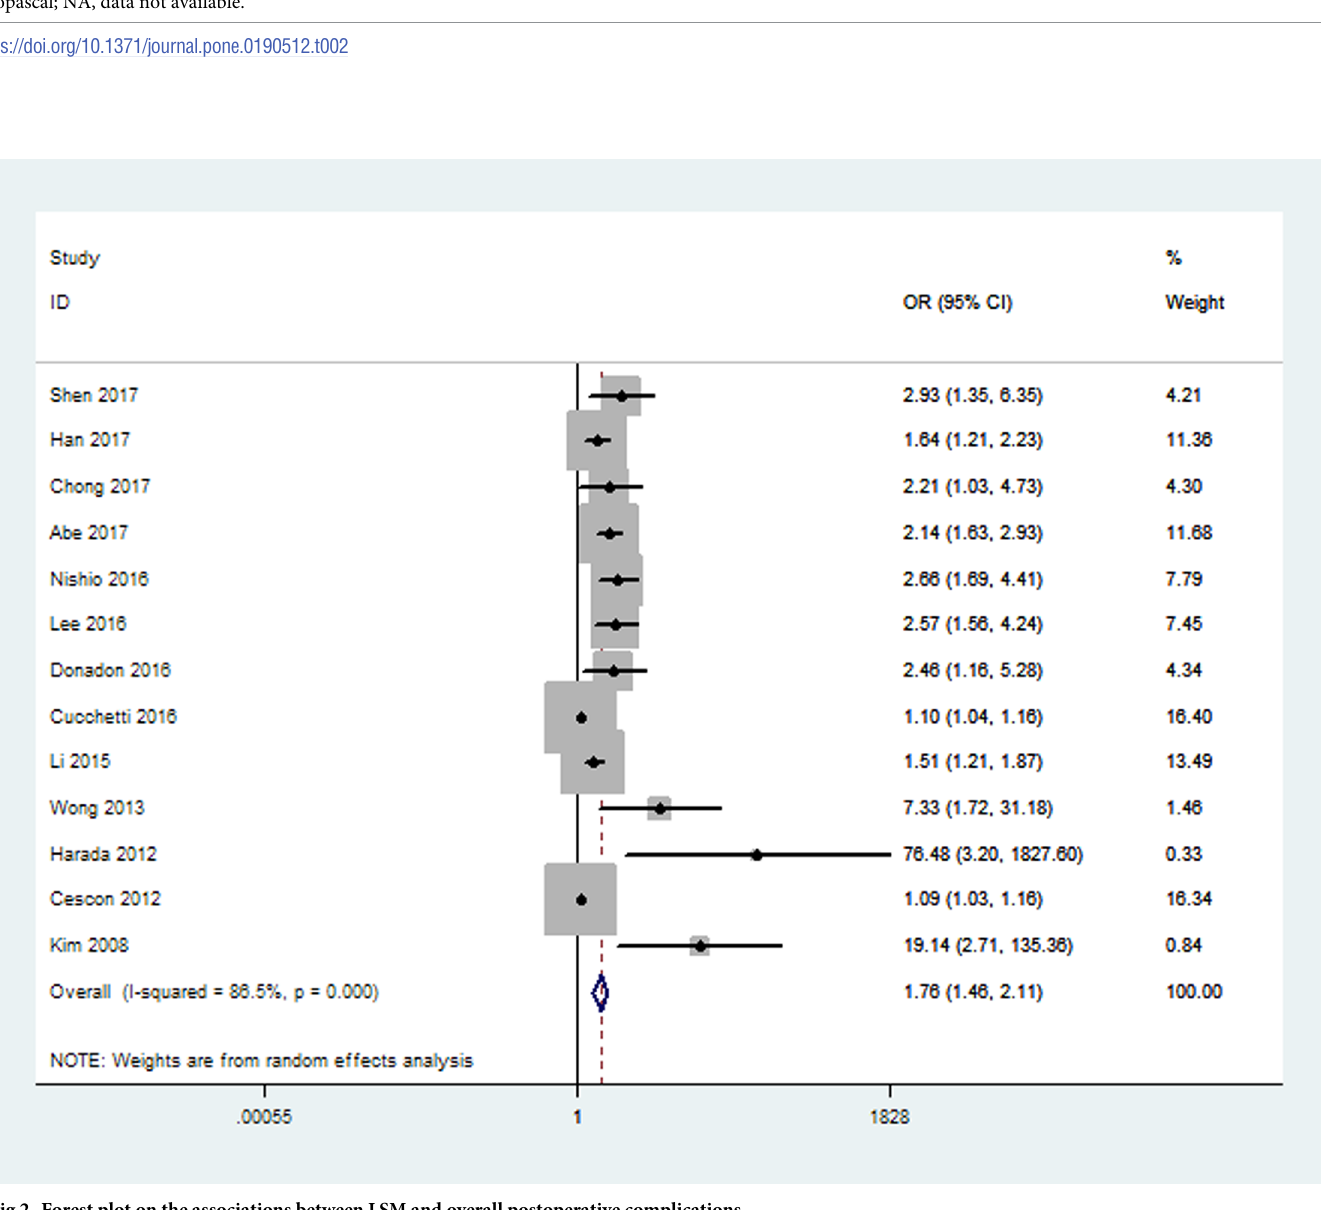
LSM, liver stiffness measurement; PHLF, Post-hepatectomy liver failure; BMI, body mass index; AUROC, area under the receiver operating characteristic curve; KPa, Kilopascal; NA, data not available.